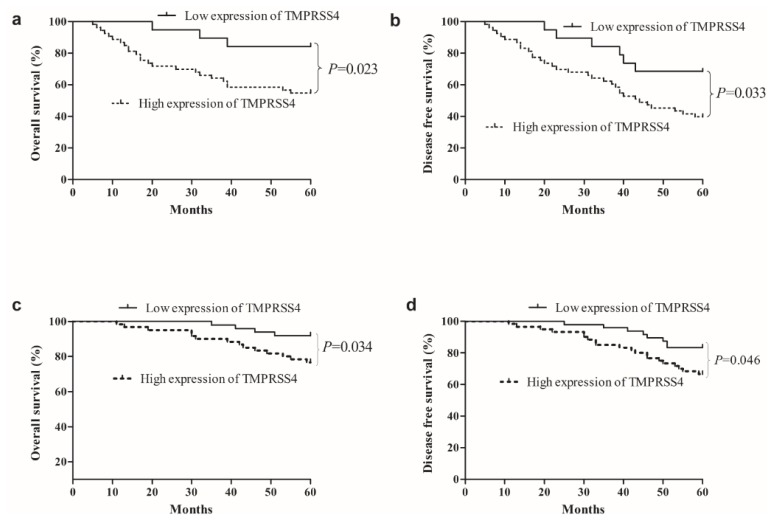
Kaplan-Meier curves for overall survival (OS) and disease-free survival (DFS) of TNBC patients stratified by TMPRSS4 expression. (a) OS curves of TNBC patients according to TMPRSS4 immunostaining; (b) DFS curves of TNBC patients according to TMPRSS4 immunostaining; (c) OS curves of non-TNBC patients according to TMPRSS4 immunostaining; (d) DFS curves of non-TNBC patients according to TMPRSS4 immunostaining. p-Values were obtained by log-rank test.